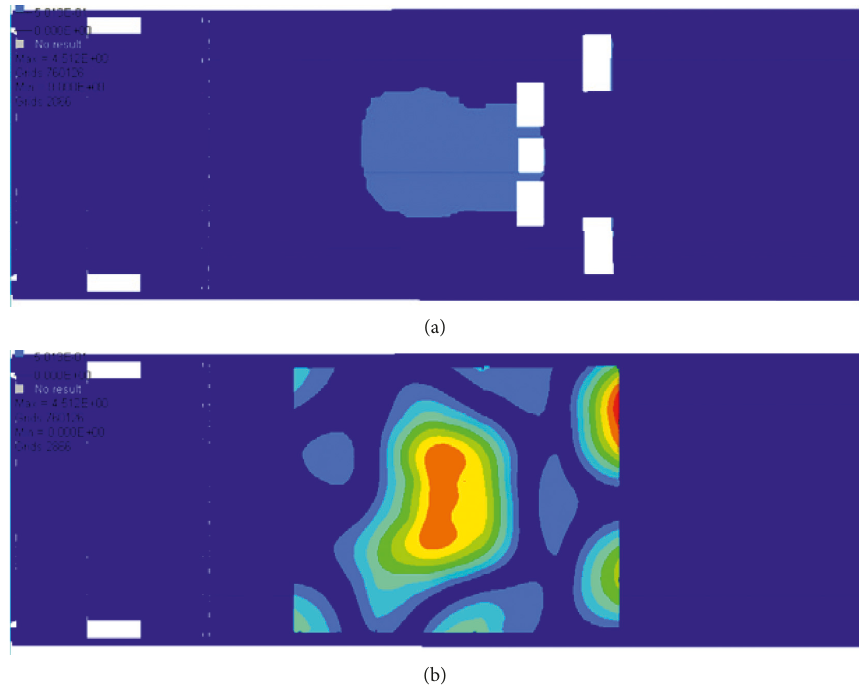
Figure 14: Modal shape comparison between (a) underframe of car body (35.25 Hz) and (b) floor .